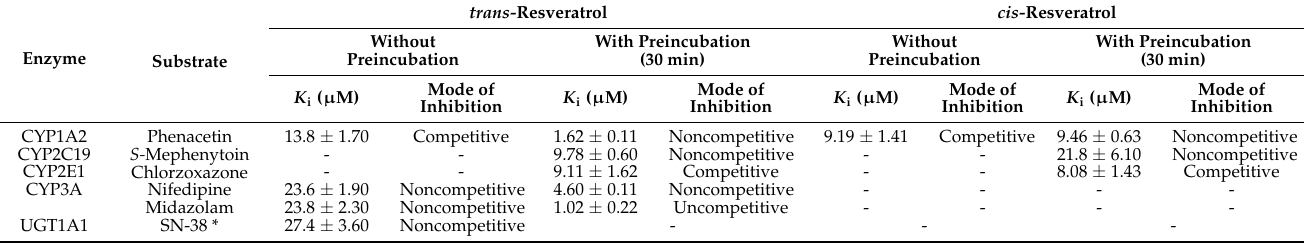
Table 4. K i values for the inhibition of CYP1A2-mediated phenacetin O -deethylatoin, CYP2C19-mediated S -mephenytoin 4-hydroxylation, CYP2E1-mediated chlorzoxazone 6-hydroxylation, CYP3A-mediated nifedipine dehydrogenation, CYP3A-mediated midazolam hydroxylation, and UGT1A1-mediated SN-38 glucuronidation activities in human liver microsomes by trans - and cis -resveratrol.